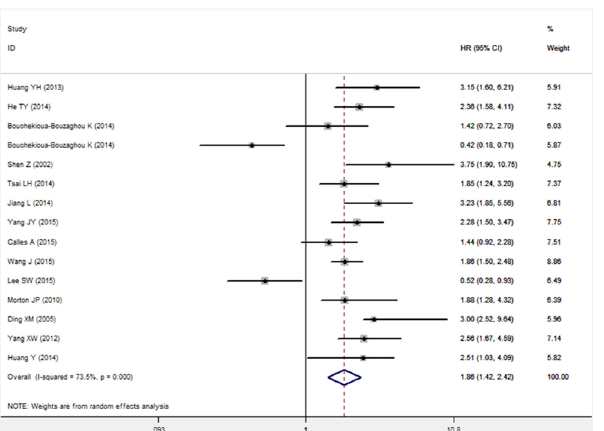
Fig 2. Forest plot describing the association between decreased LKB1 expression and